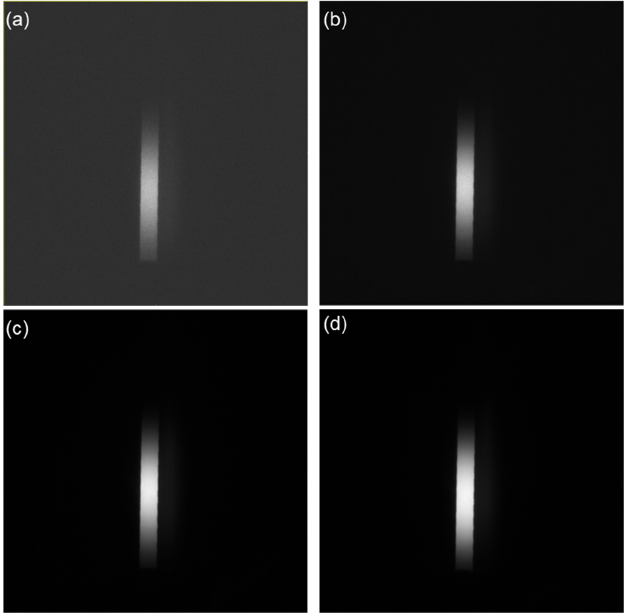
Figure 6. Typical images captured at different temperatures: ( a ) 1213 K, ( b ) 1415 K, ( c ) 1753 K and ( d ) 1835 K.